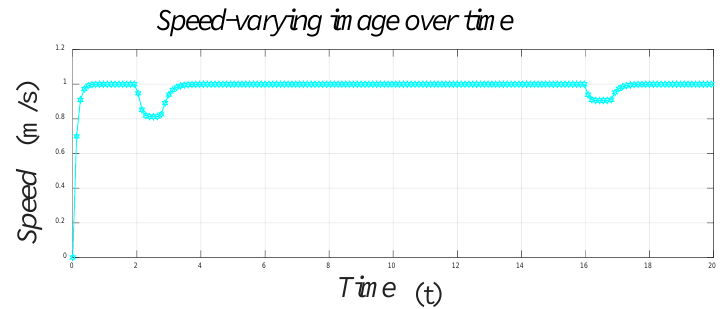
Figure 6. The speed of the robot during the movement.